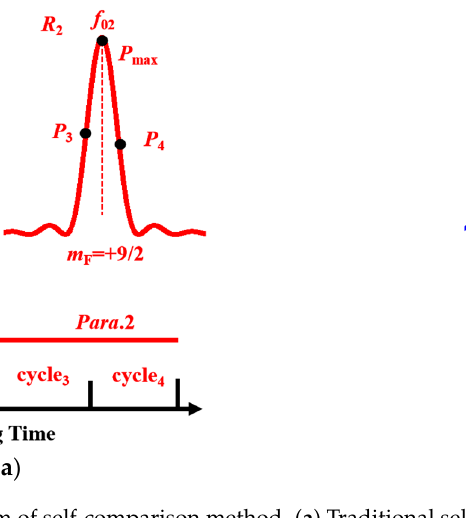
Figure 1. Schematic diagram of self-comparison method. ( a ) Traditional self-comparison method. ( b ) Drift-insensitive self-comparison method. Para .1 and Para .2 represent two different values of the same system parameter (such as atomic density, magnetic field strength); R 1 and R 2 indicate the two clock loops that operate in an interleaved way in the time domain; f 01–02 correspond to the central frequency of the spectral peaks of R 1 and R 2 , respectively; P max indicates the maximum excitation fraction; and P 1–4 are the clock transition probabilities of the first to forth clock detection cycles, respectively.